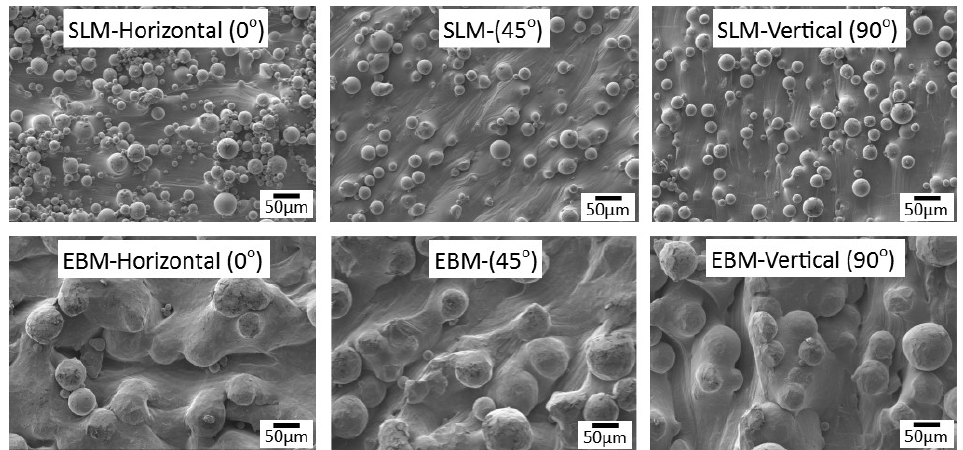
Figure 3. Surface morphology of samples built by SLM and EBM in various direction.